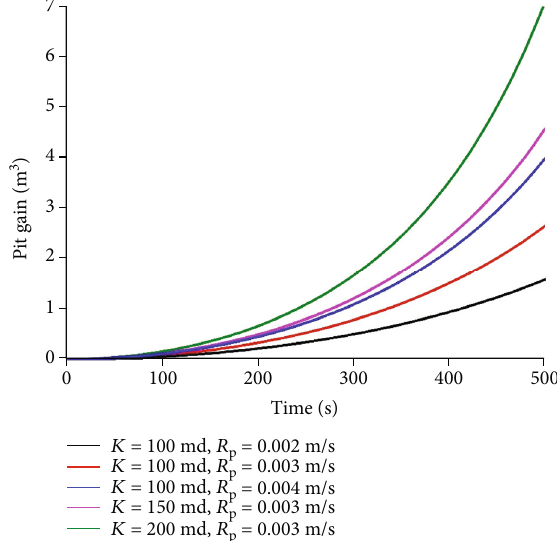
Figure 3: Sensitivity analysis of pit gains during kicks with di ff erent ROP and reservoir